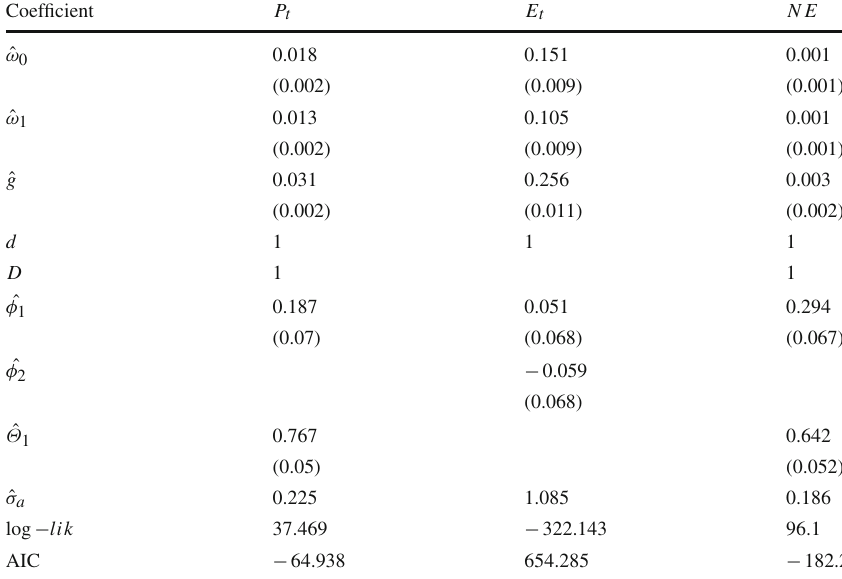
Table 4 Estimation results for the TF CPI t = (ω 0 + ω 1 L ) O t + N t with ( 1 − φ 1 L − φ 2 L 2 ) ∇ d ∇ D